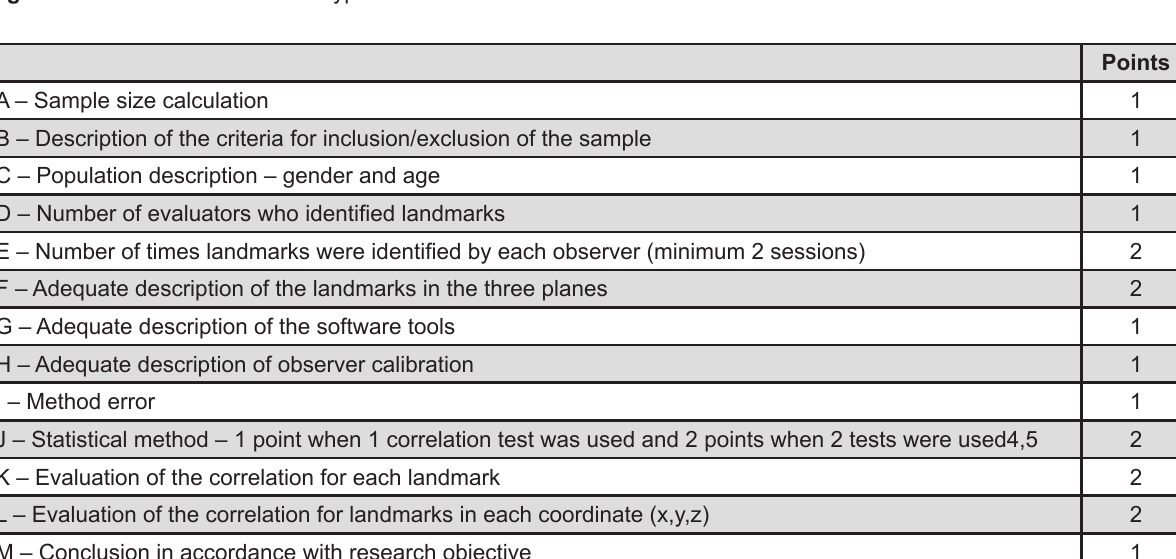
Figure 2- PECO Format and null hypothesis